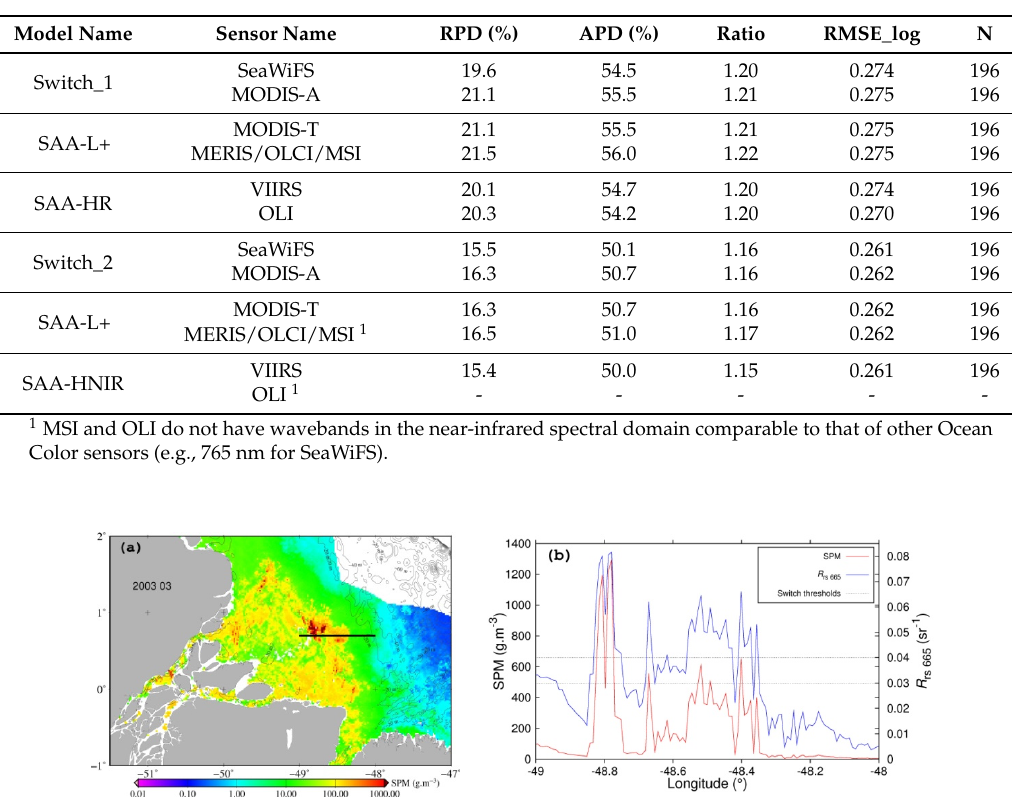
Figure 9. ( a ) Monthly SPM image (March 2003) obtained by applying the SAA generic algorithm (Equations (13)–(15)) to the monthly mean MERIS data collected over the Amazon coastal waters. The black line on the image represents the location of the transect over which the SPM and R rs (665) data are extracted; ( b ) Spatial evolution of SPM and R rs (665) along the transect. The two dashed lines indicate the adopted switching thresholds.